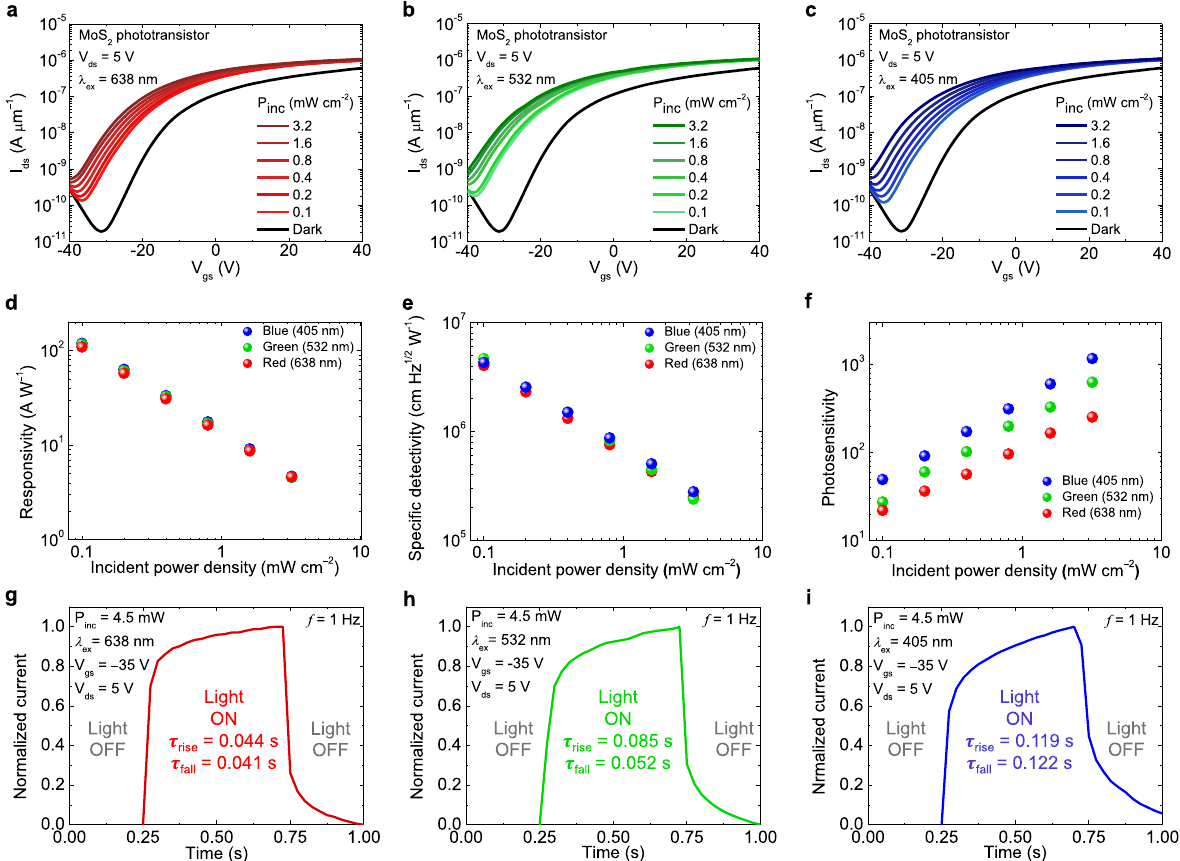
Fig. 5 Photoresponsive characteristics of a bilayer MoS 2 phototransistor in the image sensor array. I ds – V gs curves of a transparent top-gate phototransistor based on bilayer MoS 2 channel and IZO top-gate at V ds = 5 V under a red, b green, and c blue light illumination with various incident power densities ( λ ex = 638 nm (R), 532 nm (G), and 405 nm (B), and P inc = 0.1, 0.2, 0.4, 0.8, 1.6, 3.2 mW cm − 2 ). d Photoresponsivity, e speci fi c detectivity, and f photosensitivity of the MoS 2 phototransistor under R, G, B light illumination calculated from Fig. 4a – c. g – i Photoswitching characteristics of the MoS 2 phototransistor under temporal light illumination with λ ex = 638, 532, and 405 nm, respectively. All switching curves were measured at V ds = 5 V, V gs = − 35 V, and P = 4.5 mW cm − 2 with illumination frequency of 1 Hz. Rise and fall times were extracted from 20% to 80% and from 80% to 20% of the inc maximum current,